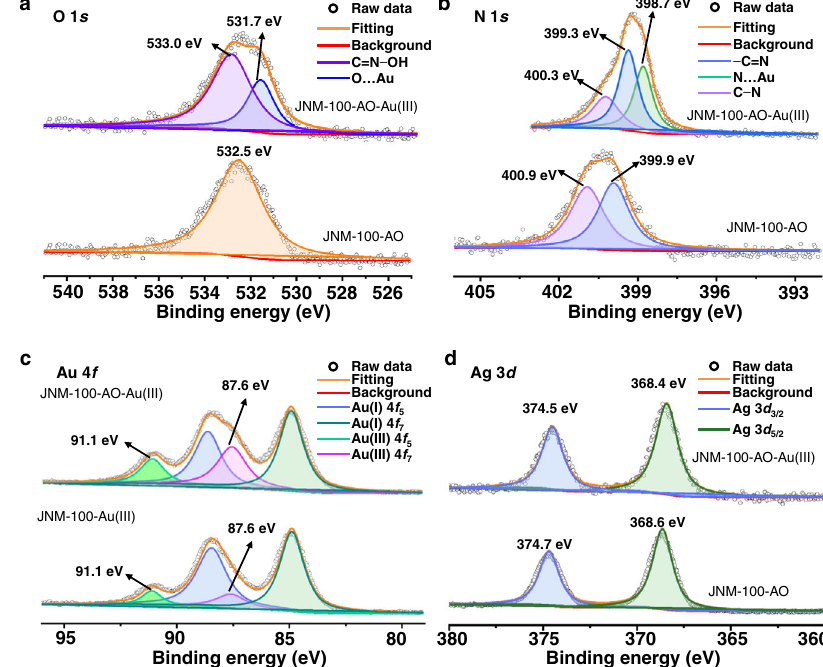
Fig. 5 | Mechanistic investigation with XPS analysis. XPS spectra of a O 1 s , b N1 s , and d Ag 3 d for JNM-100-AO (before adsorption of Au 3+ ) and JNM-100-AO-Au(III) (adsorbed Au 3+ samples). c XPS spectra of Au 4f for JNM-100-Au(III) and